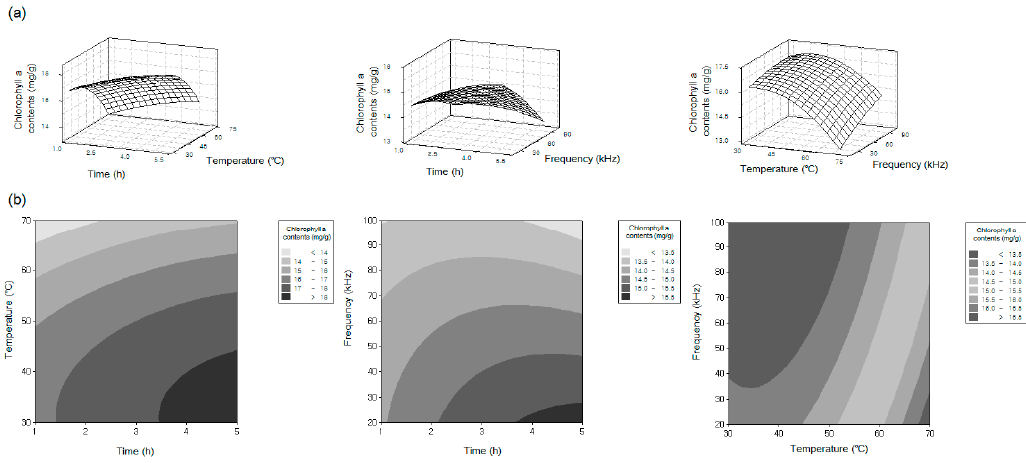
Figure 1. 3D response surfaces ( a ) and contour plots ( b ) as a function of ultrasonic frequency, temperature, and process time.